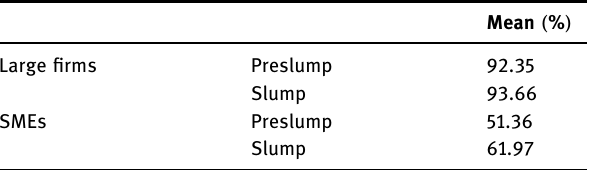
Table 2: Export participation of large fi rms and SMEs during the preslump and slump periods